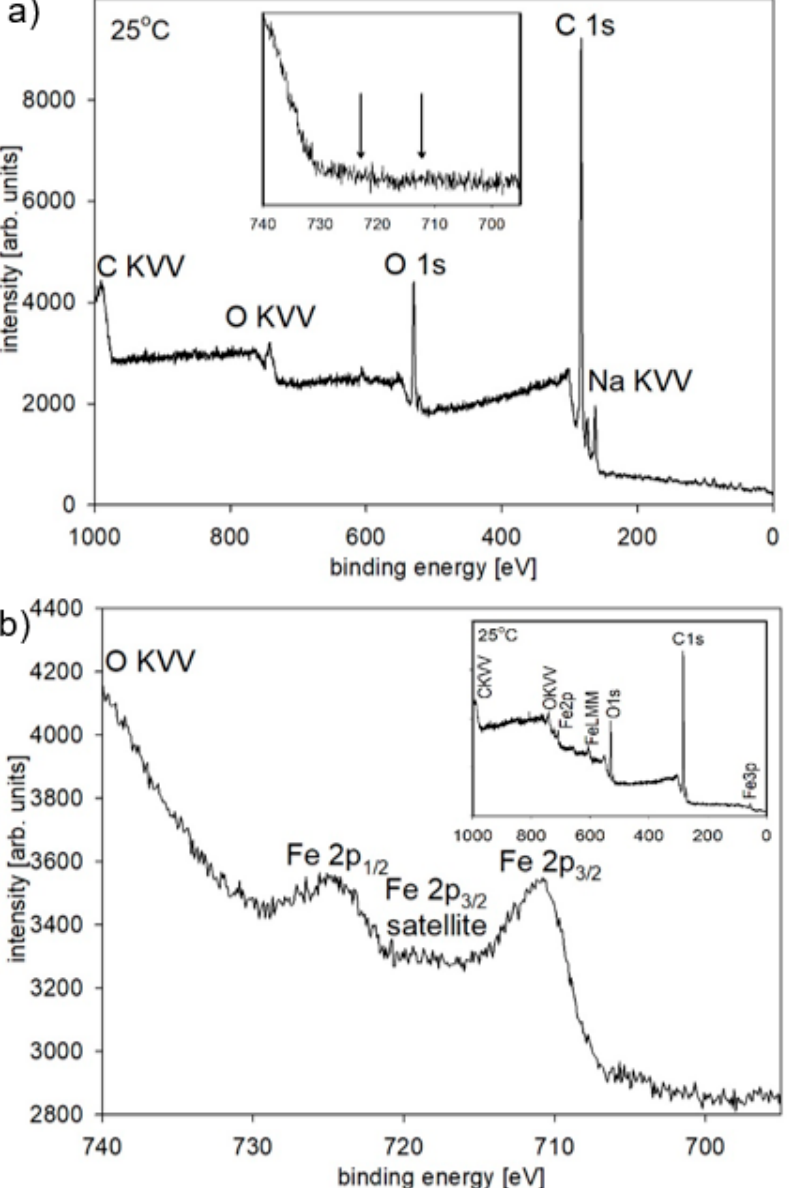
Figure 7. The XPS spectra of the Fe nanowires were measured after membrane dissolution ( a ), and on the over-deposited caps formed on the membrane surface—( b ). The insets show the detail ( a ) and survey scans ( b ). The arrows indicate the positions of the Fe2p 1/2 and Fe 2p 3/2 peaks.